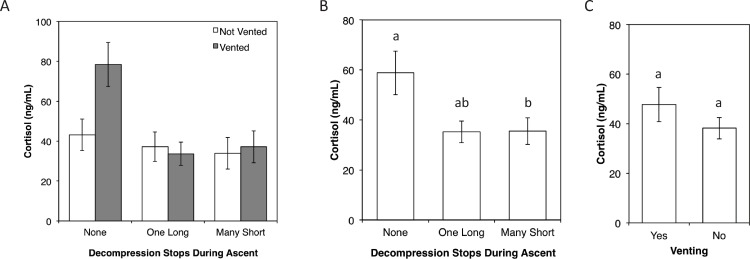
Cortisol concentration (mean ± SE) by each treatment.(A) venting and ascent treatments; (B) ascent treatments; and (C) venting treatments. Letter groups represent Tukey’s multiple range test results comparing means. All treatment groups were significantly elevated above the ocean baseline concentration of 8.9 ng/ml.